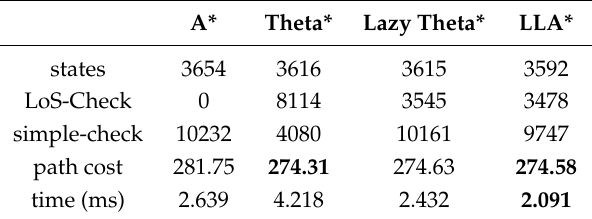
Table 4. Planning results of the maze test